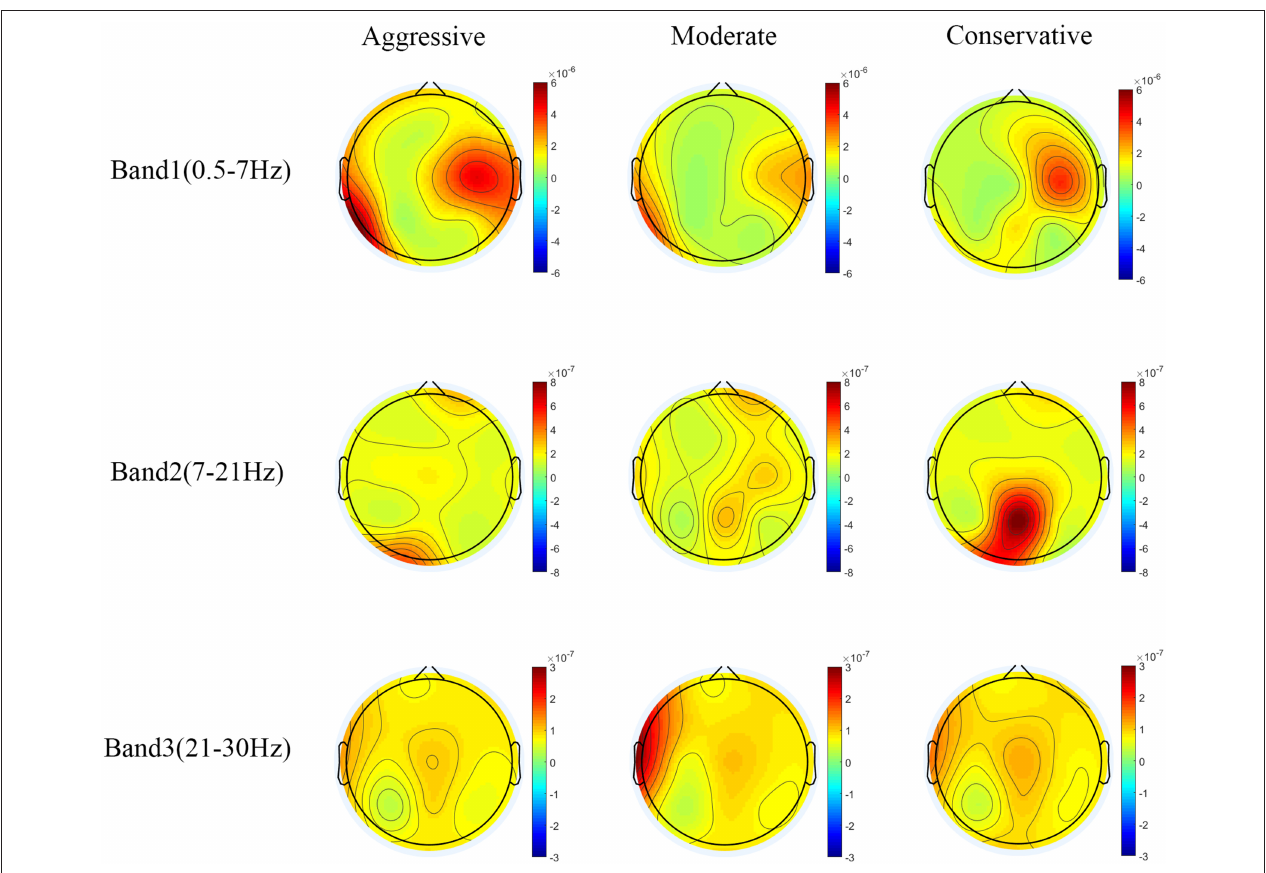
FIGURE 6 | Power topographic maps for the three driving styles in four bands.